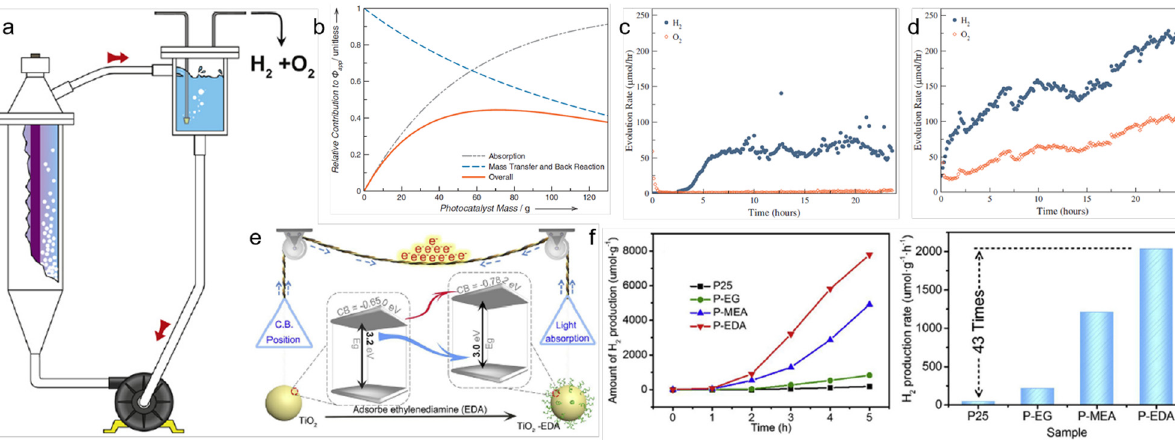
Figure 7: ( a ) Schematic of the photocatalytic water - splitting reaction in a fl uidized bed system. ( b ) The individual contributions of photon absorption, mass transfer, and the back reaction to the apparent quantum e ffi ciency as a function of photocatalyst mass. The rate of hydrogen and oxygen evolution over time ( c ) under normalconditions and ( d ) after improving turbulence and liquid – gascontact, reprinted with permission from ref. [ 177 ] , Copyright ( 2018 ) Elsevier. ( e ) Schematic of the general procedure used to prepare the target photocatalysts P - EDA. ( f )